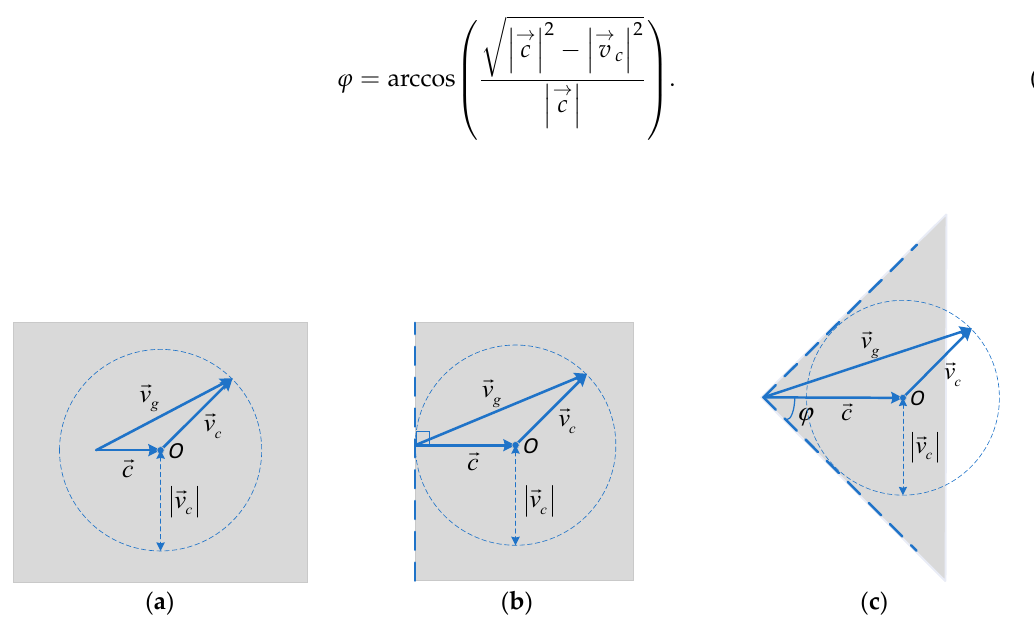
Figure 2. Reachable region. The stronger the current is, the more the reachable region (gray region) by the vehicle reduces. ( a ) (cid:12) (cid:12) → v = 0.5 m/s. (cid:12) (cid:12) speed is v c is c (cid:12) (cid:12) = 0.5